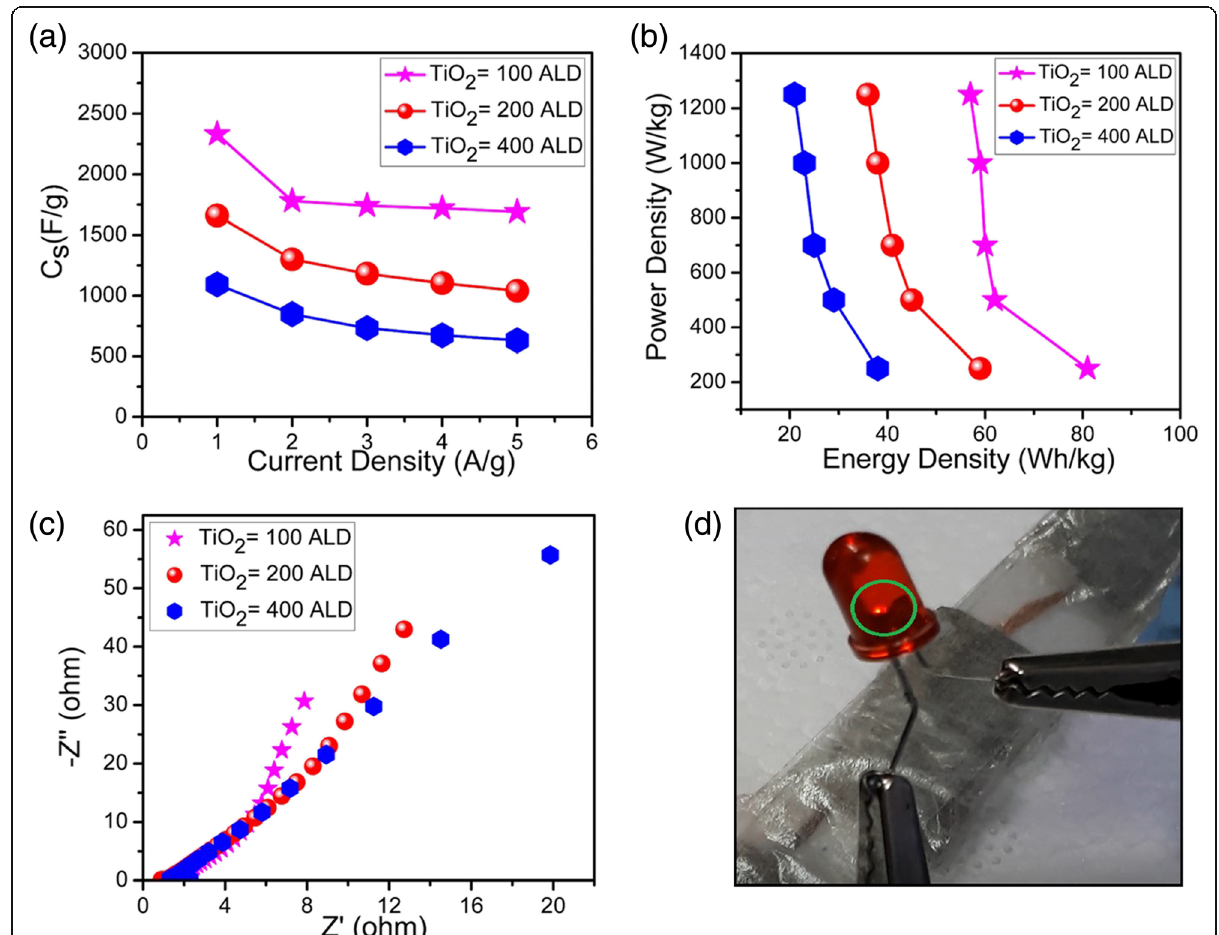
Fig. 4 Performance comparison of TiO 2 NMs electrodes. a Specific capacitances of the TiO 2 NM electrodes at various current densities. b Ragone plot of TiO 2 NMs electrodes with 100, 200, and 400 ALD cycles. c Nyquist plot of three TiO 2 NMs electrodes. d A photo showing that two supercapacitors in series can lighten up a red